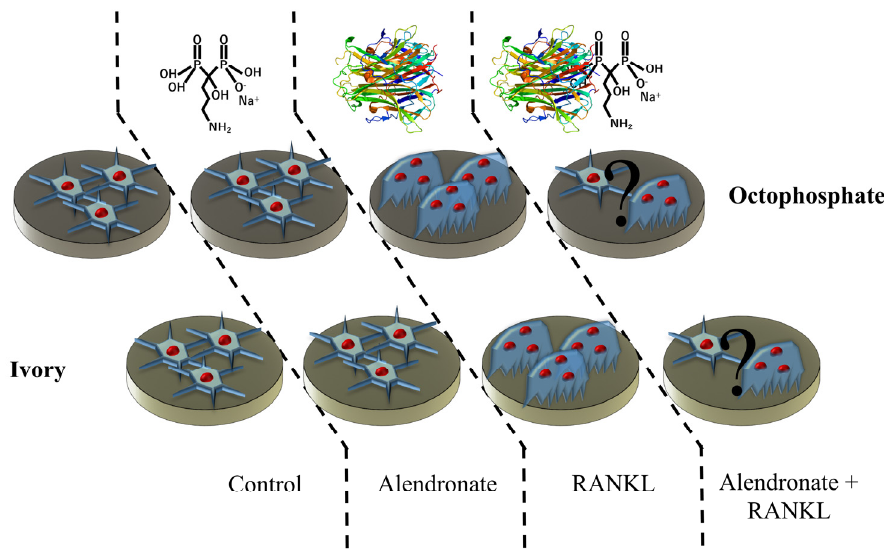
Figure 1. Experimental setting showing the different substrates and